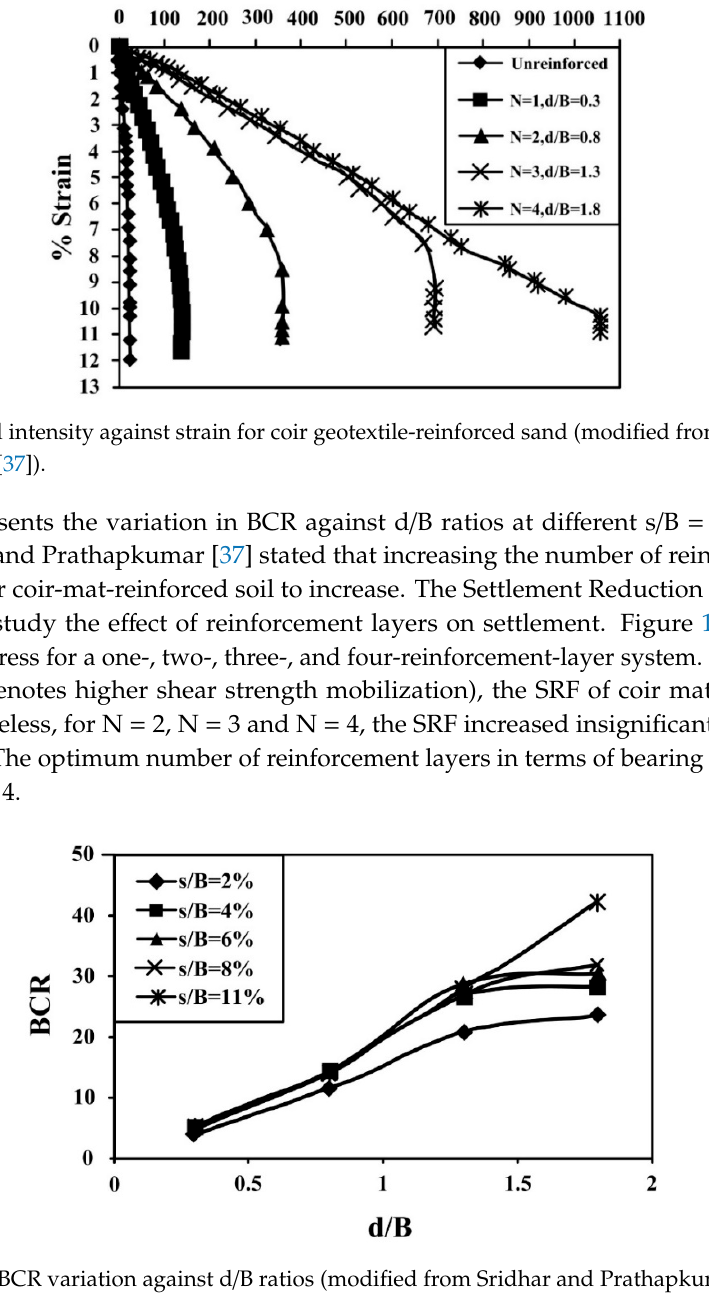
Figure 14. Settlement reduction factor variation against stress (modified from Sridhar and Prathapkumar [37]).